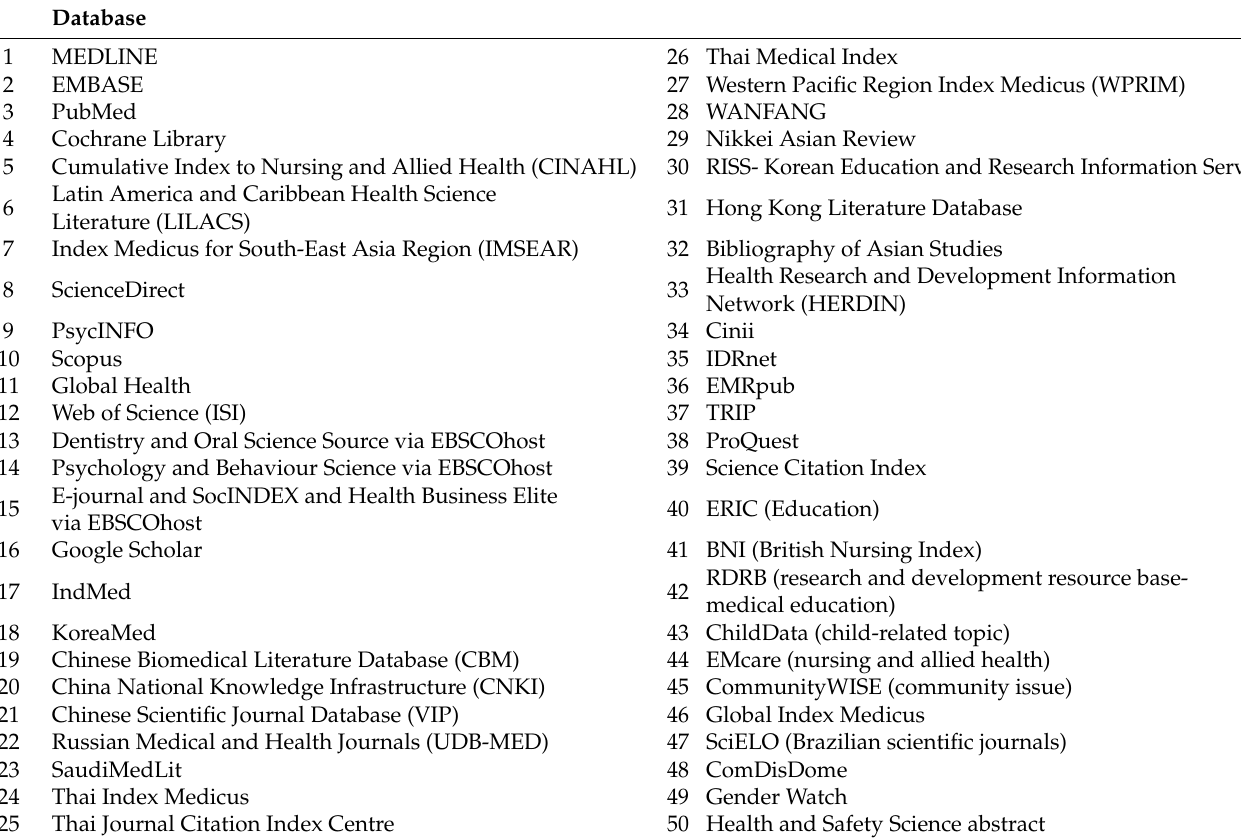
Table 5. List of eligible databases ( n =